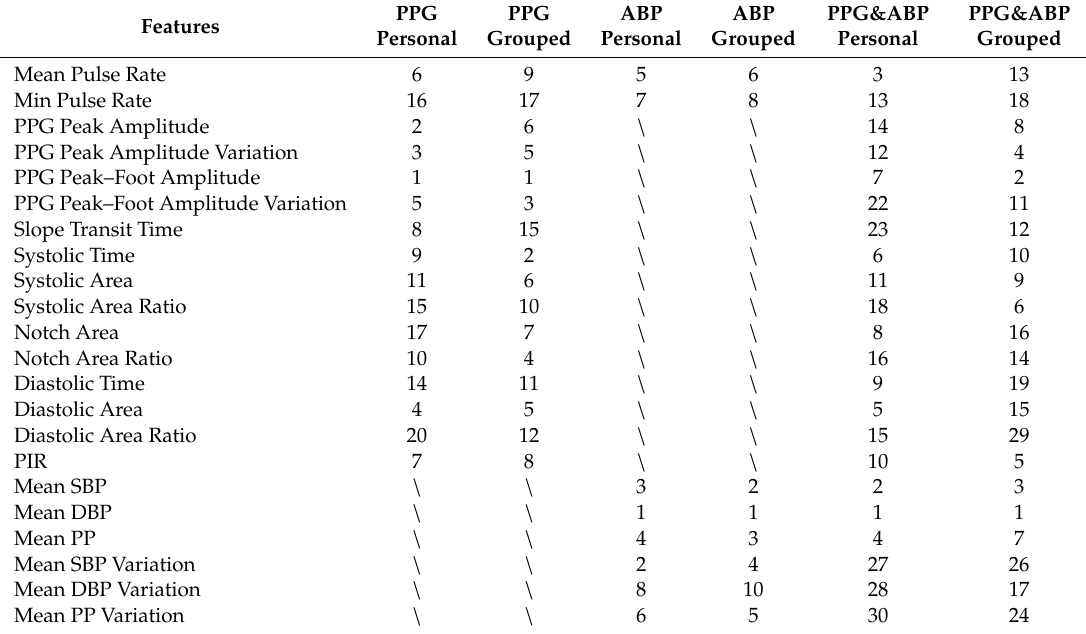
Table 4. Features’ importance ranking in RF models.